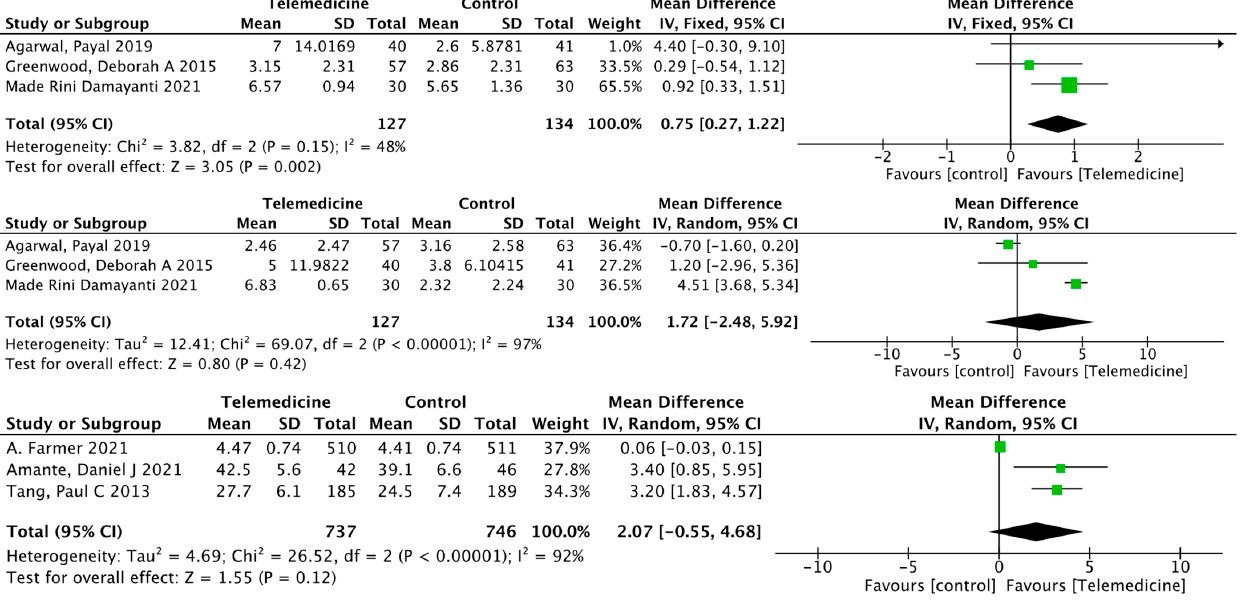
Figure 12. Mean difference in the changes in exercise, foot care, and satisfaction levels for telemed- icine and usual care interventions. and usual care